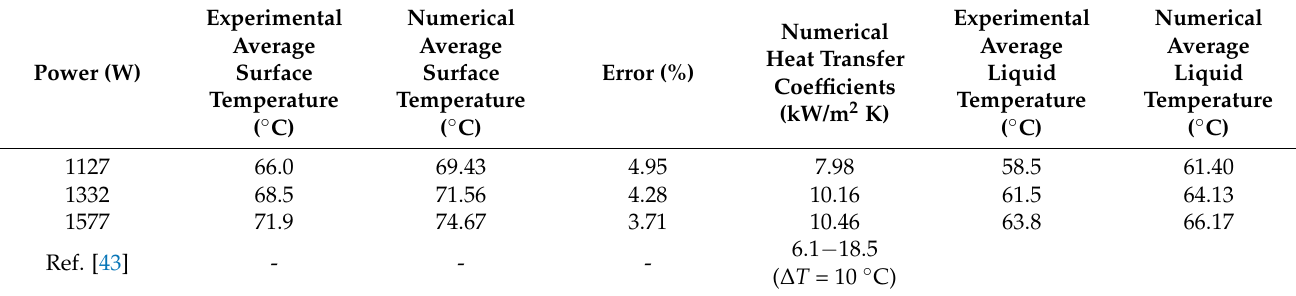
Table 5. Verification of the proposed CFD